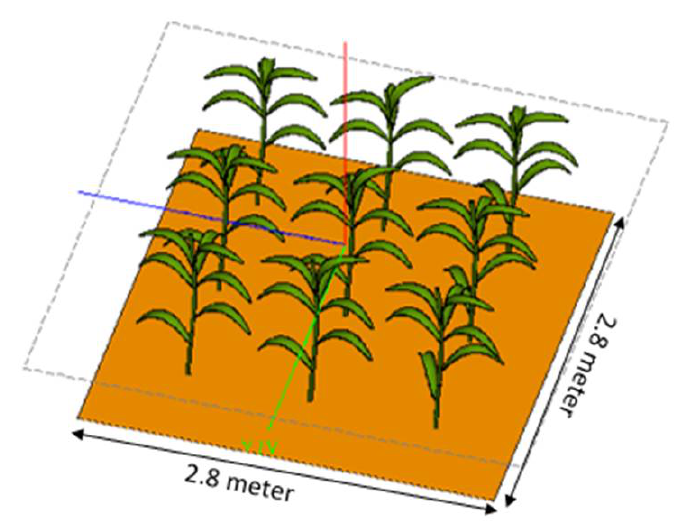
Figure 2. Quasi-periodic arrangement of 9 corn plants in the simulation. The displacement is not periodic, ∆ d = [ 0,0.05 d ] where d = 0.85 m . We make use of several key elements of such Monte Carlo simulations.